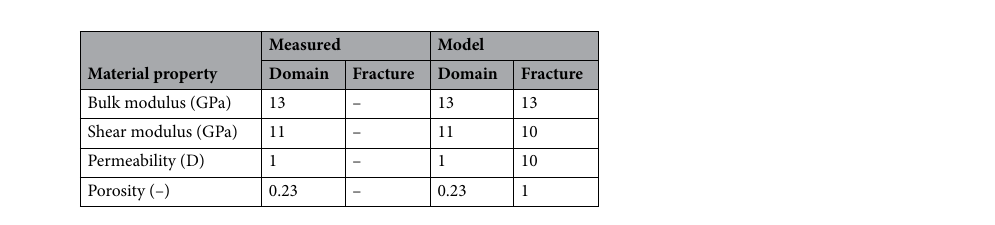
Table 1. Material properties of Bentheim sandstone and the corresponding model parameters 11 .